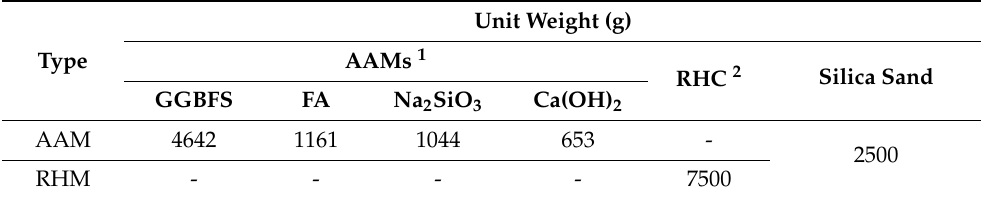
Table 2. Mixture design for binder jetting 3d printing (alkali-activated mortar (AAM), rapid harden- ing mortar (RHM)).